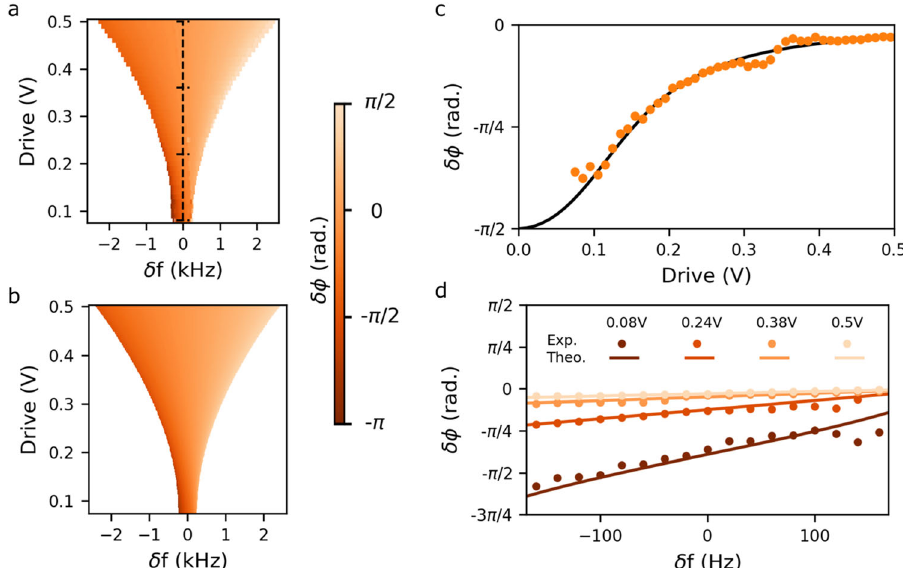
Fig. 2 Phase variation within the synchronization range. As the drive F osc is changed, the ratio between the perturbation and the drive F e = F osc is kept at a constant level of 10%. As the tone of the perturbation is detuned from the frequency of the free running oscillator, their phase difference δφ adjusts to maintain synchronization ( a : experimental results, b : model). c Cross-section of panels ( a , b ) along δ f ¼ 0, where the phase delay between the oscillator and the perturbation shrinks as the system enters the nonlinear regime (line: theory, dots: experiment). d Cross-sections of panels ( a , b ) along different drive levels near zero detuning, where the phase delay varies less with the increasing Duf fi ng nonlinearity. Measurement errors mainly arise from frequency drifts on the order of 20 Hz, close to the distance between two consecutive points.